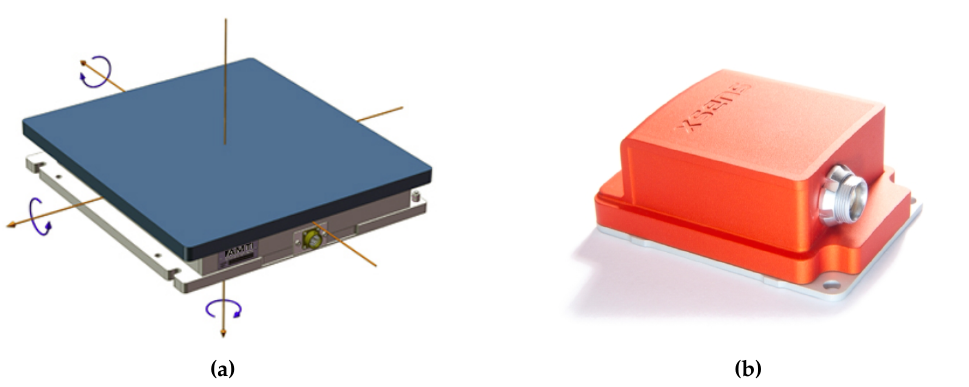
Figure 2. Sensors used in the experiment: a force platform AMTI OR6 ( a ) and an inertial sensor Xsens MTx comprising both accelerometer and gyroscope ( b